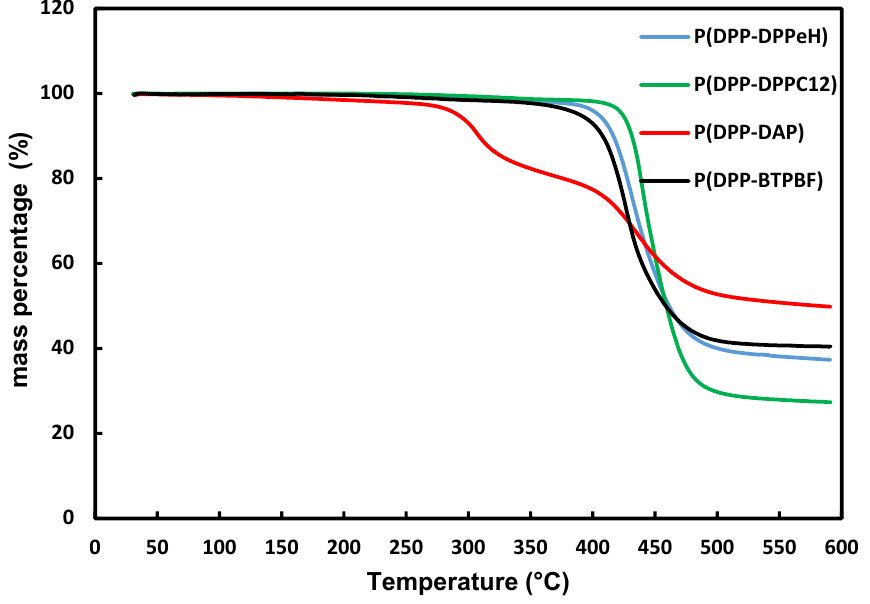
Figure 6. TGA of copolymers P(DPP-DPPeH), P(DPP-DPPC12), P(DPP-DAP), and P(DPP-BTPBF) with a heating ramp of 10 °C min ‐ 1 up to 600 °C under N 2 flux.